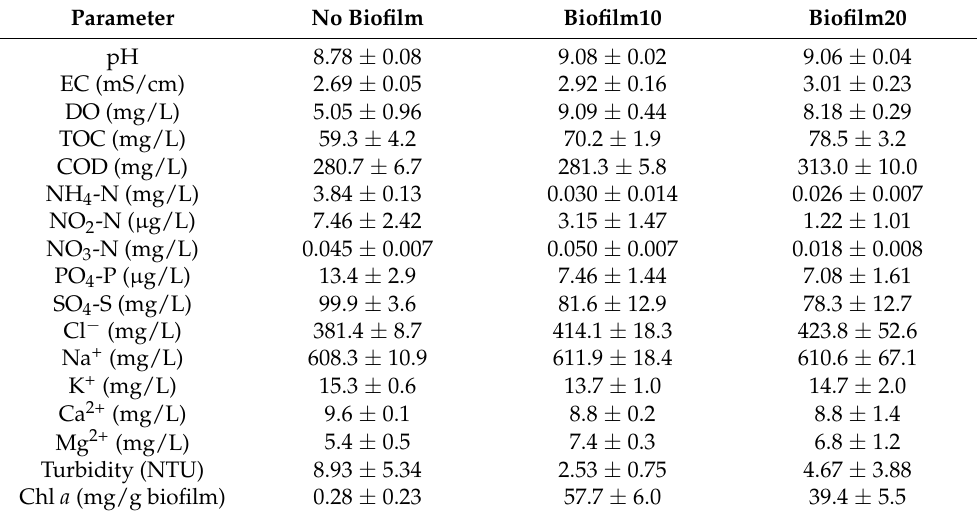
Table 2. Surface water chemistry data and Chl a biofilm concentrations in No Biofilm, Biofilm10, and Biofilm20 jars prior to mixing tests. Results are presented as average ± one standard deviation of replicates. Biofilm10 corresponds to 10-week-old biofilms; Biofilm20 corresponds to 20-week- old